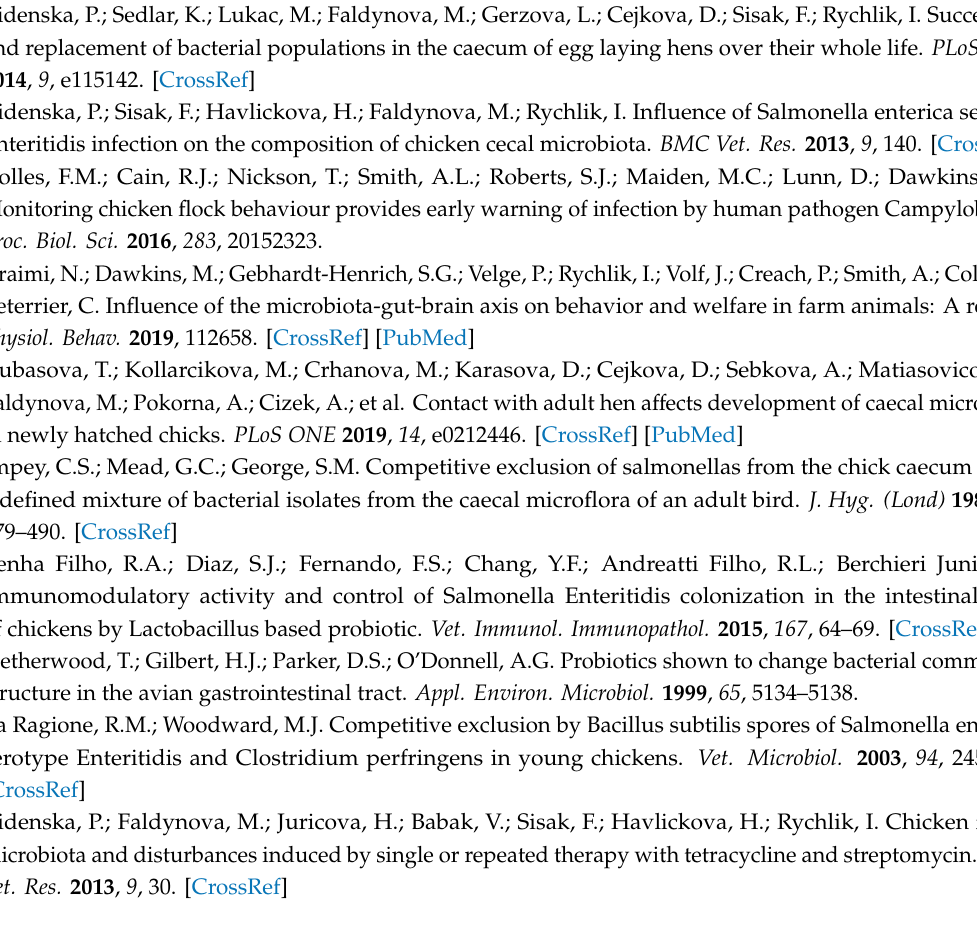
Table S1: List of all media tested in this study, Table S2: OTU table with percentage abundance of particular OTU in particular sample, Figure S1: Taxonomic classification of the most common bacterial isolates colonising the chicken caecum and their ability to grow in vitro . Figure S2: Identification of the most selective growth conditions. Figure S3: Growth of major families in particular nutrient media in vitro